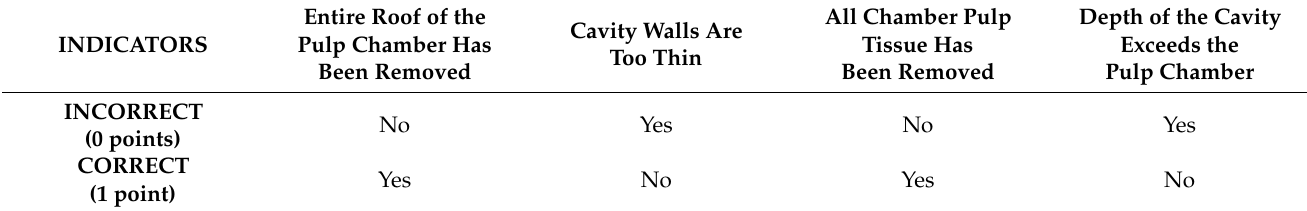
Table 2. Evaluation guide.